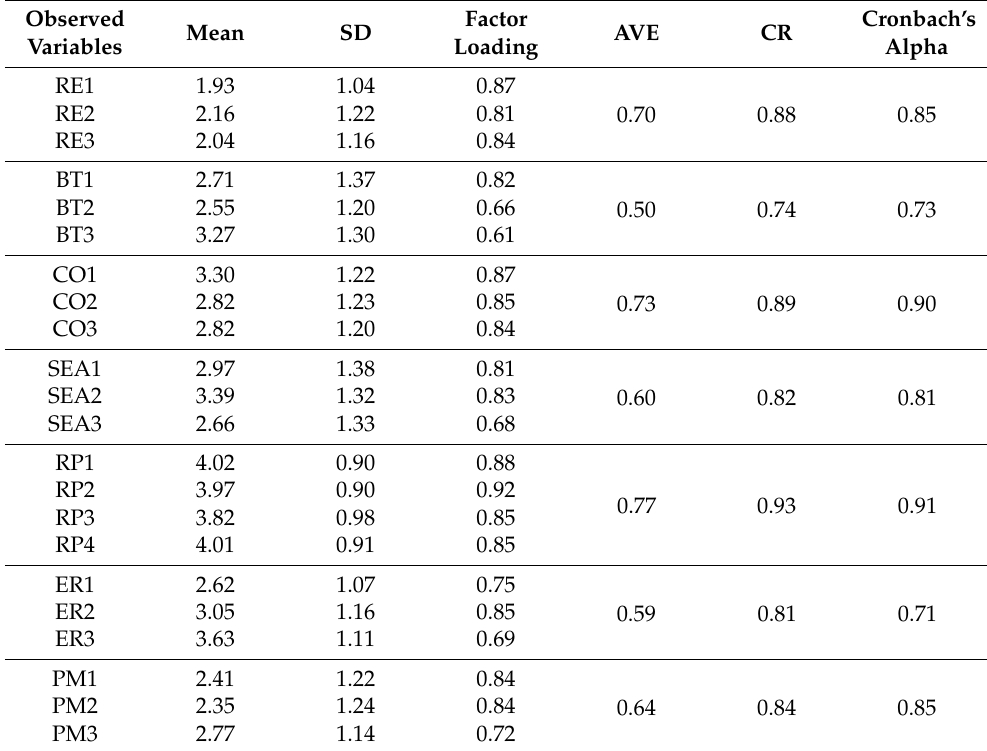
Table 3. Statistics and questionnaire test of the observed